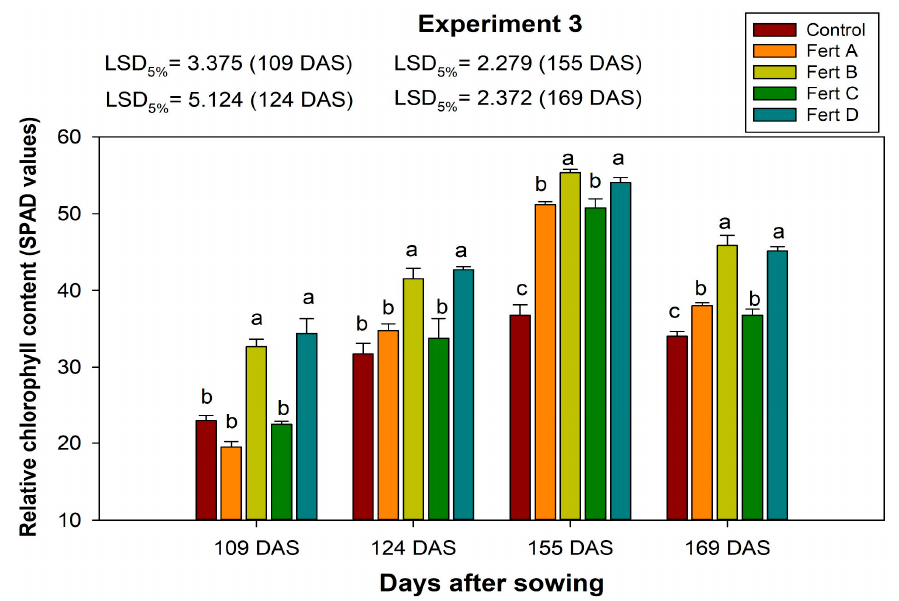
Figure 8. Relative chlorophyll content (SPAD values) in the leaves of bristly oxtongue plants as affected by various fertilization regimes. For each sampling date, bars followed by the same letters were not found to significantly differ with Fisher’s least significant difference (LSD) test. Errors bars show the Standard Error values. Final measurement (source of variation: treatments): Fvalue = 52.242, p < 0.001, DF (degrees of freedom) = 4.